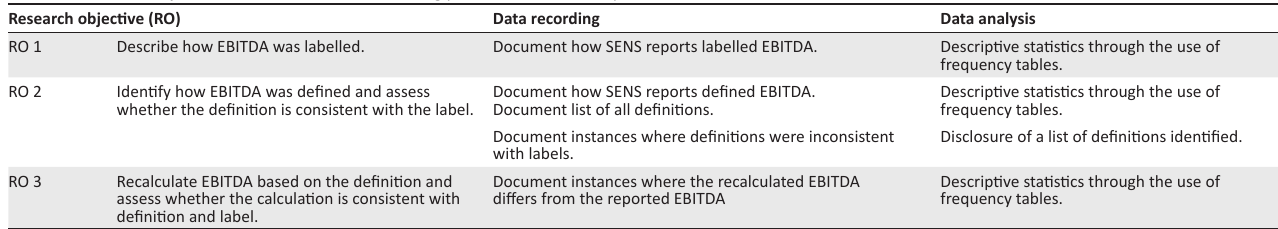
TABLE 2: Research objectives linked to the data recording process and data analysis. Research objective (RO)